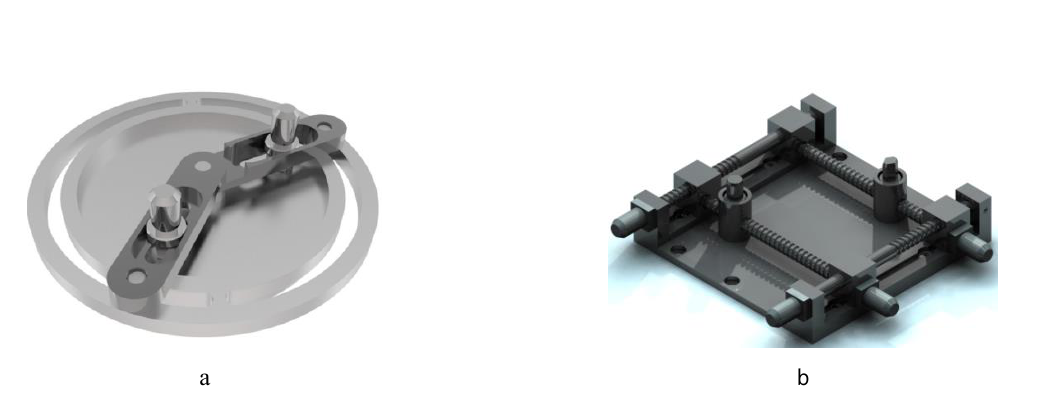
Figure 3. Adjustable locating modules for locating of prismatic parts according to plane and two holes